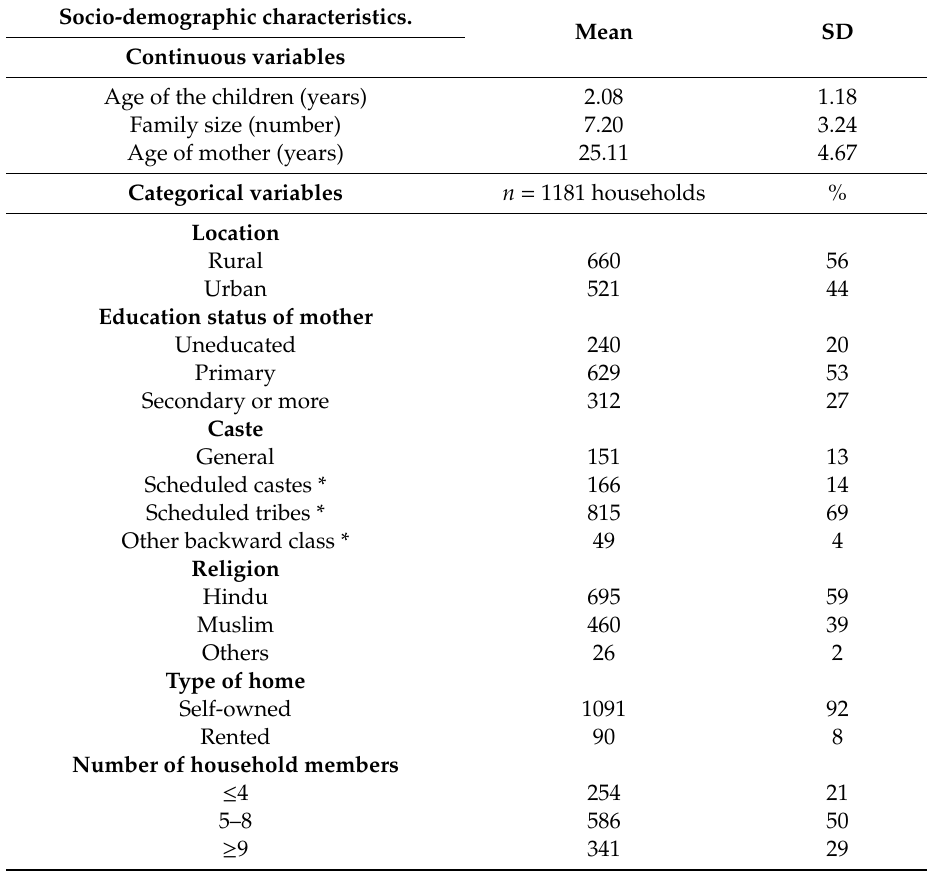
Table 1 provides the socio-demographic characteristics of the study participants. Table 1. Socio-demographic characteristics of 1181 households having 1571 children included in the